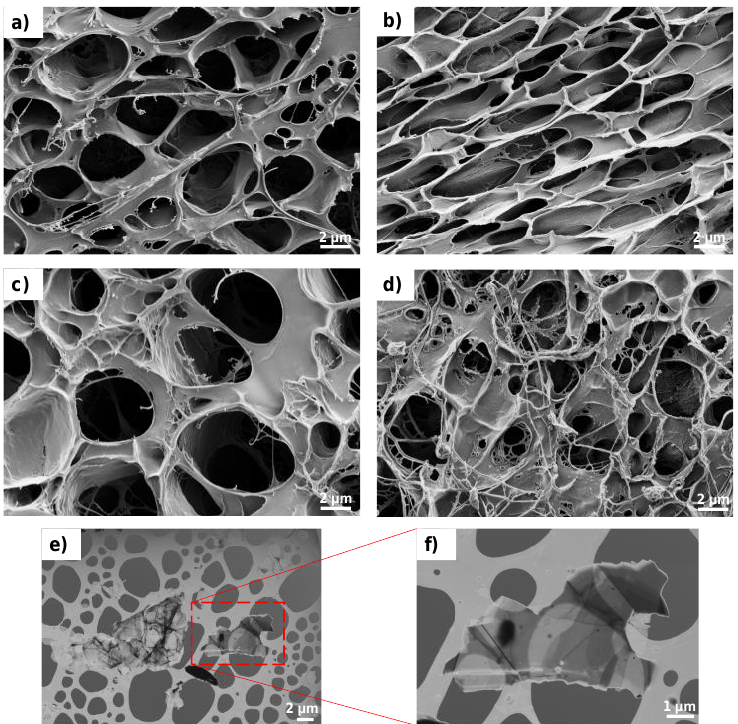
Figure 2. ( a ) High-resolution FESEM surface images of the hydrogels: ( a ) c-PVA, ( b ) c-PHBV/PVA, ( c ) c-PHBV/PVA 0.2% G, and ( d ) c-PHBV/PVA 0.8% G. ( e , f ) Aggregated and detailed single-form